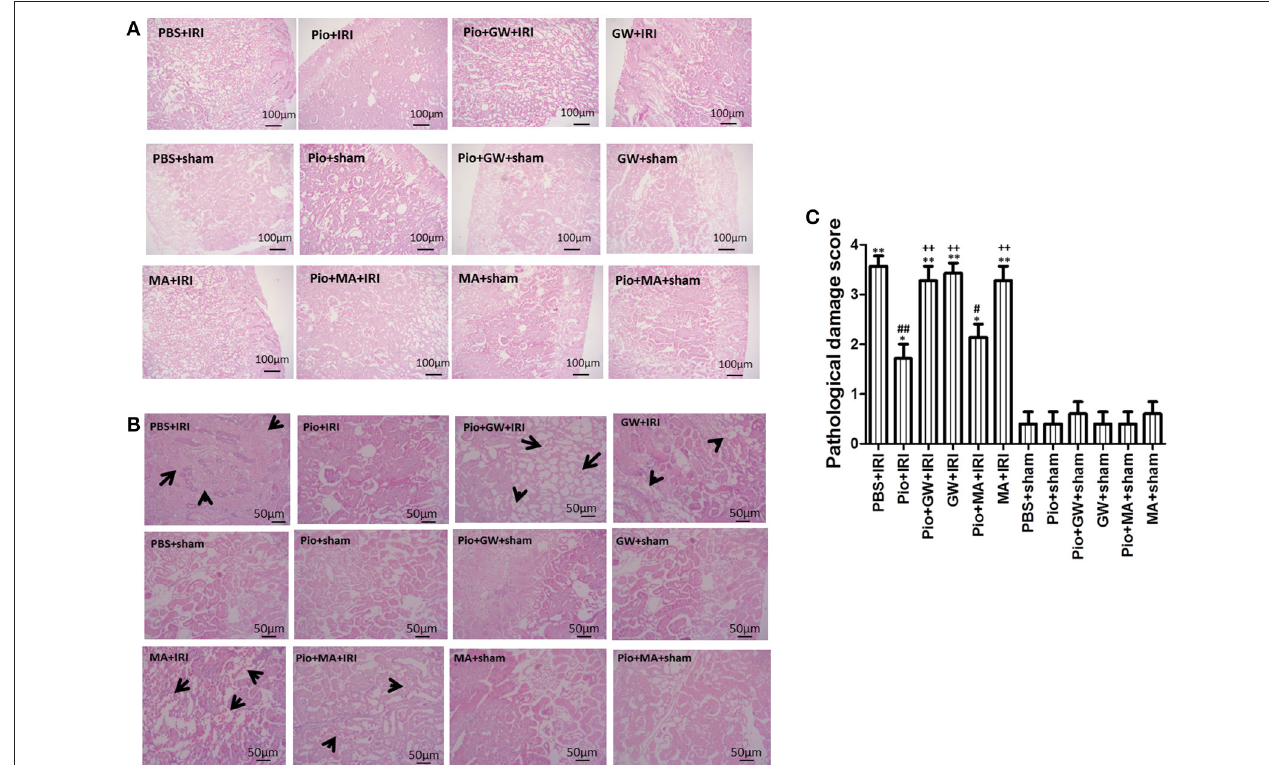
FIGURE 3 | Histological evaluation of renal tissue at 24h after renal IRI. (A) (original magnification 100x), (B) (original magnification 200x) Representative photographs of kidney sections stained with hematoxylin and eosin. (C) Histological scores in kidney sections. Arrows indicate tubular dilatation, swelling, congestion, vacuolization and tubular necrosis in the kidneys. Compared with the PBS + sham group, *represents for P < 0.05, **represents for P < 0.01; Compared with the PBS + IRI group, # represents for P < 0.05, ## represents for P < 0.01; Compared with the Pio + IRI group, ++ represents for P < 0.01. n = 6 in each group.